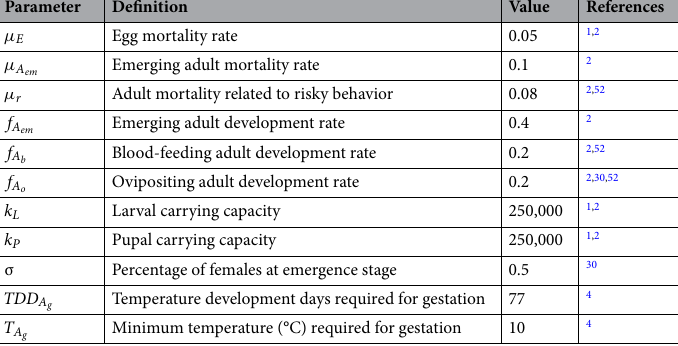
Table 3. Constant